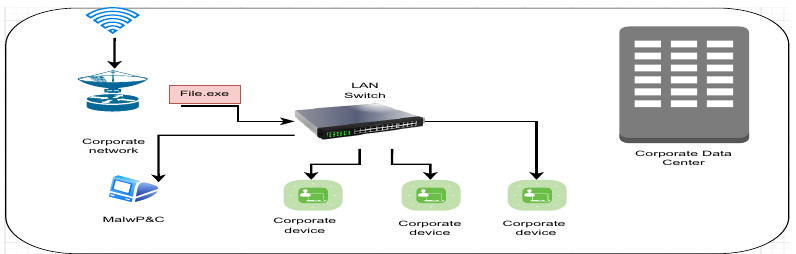
Figure 2. Malware categorization scenario visualization.